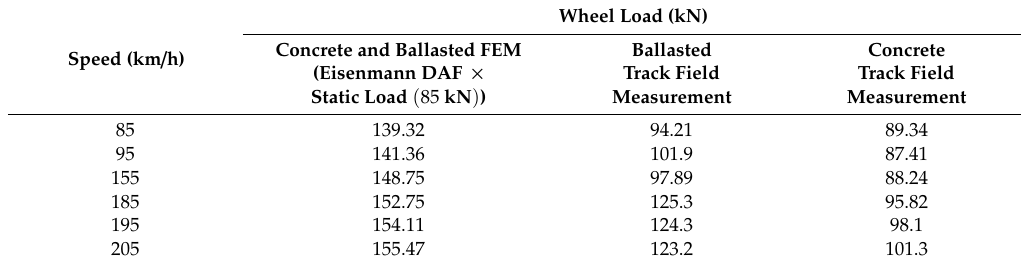
Table 9. Ballasted track field measurement result summary.